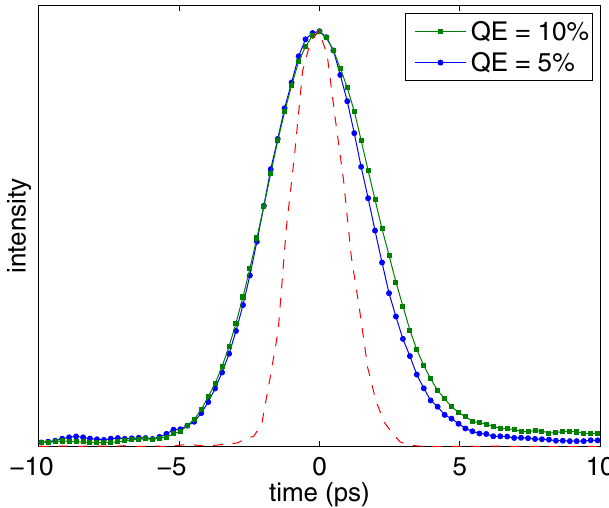
FIG. 8. (Color) Temporal response obtained from GaAs ( QE (cid:2) 5 , 10%) excited by 1 ps rms 520 nm laser pulse. The dashed line shows the profile obtained when the deflecting cavity is not powered. Gaussian fits provide 1.8 ps (solid, QE (cid:2) 5% ) and 0.9 ps (dashed) standard deviation. Refer to text for the infor- mation on the measurement